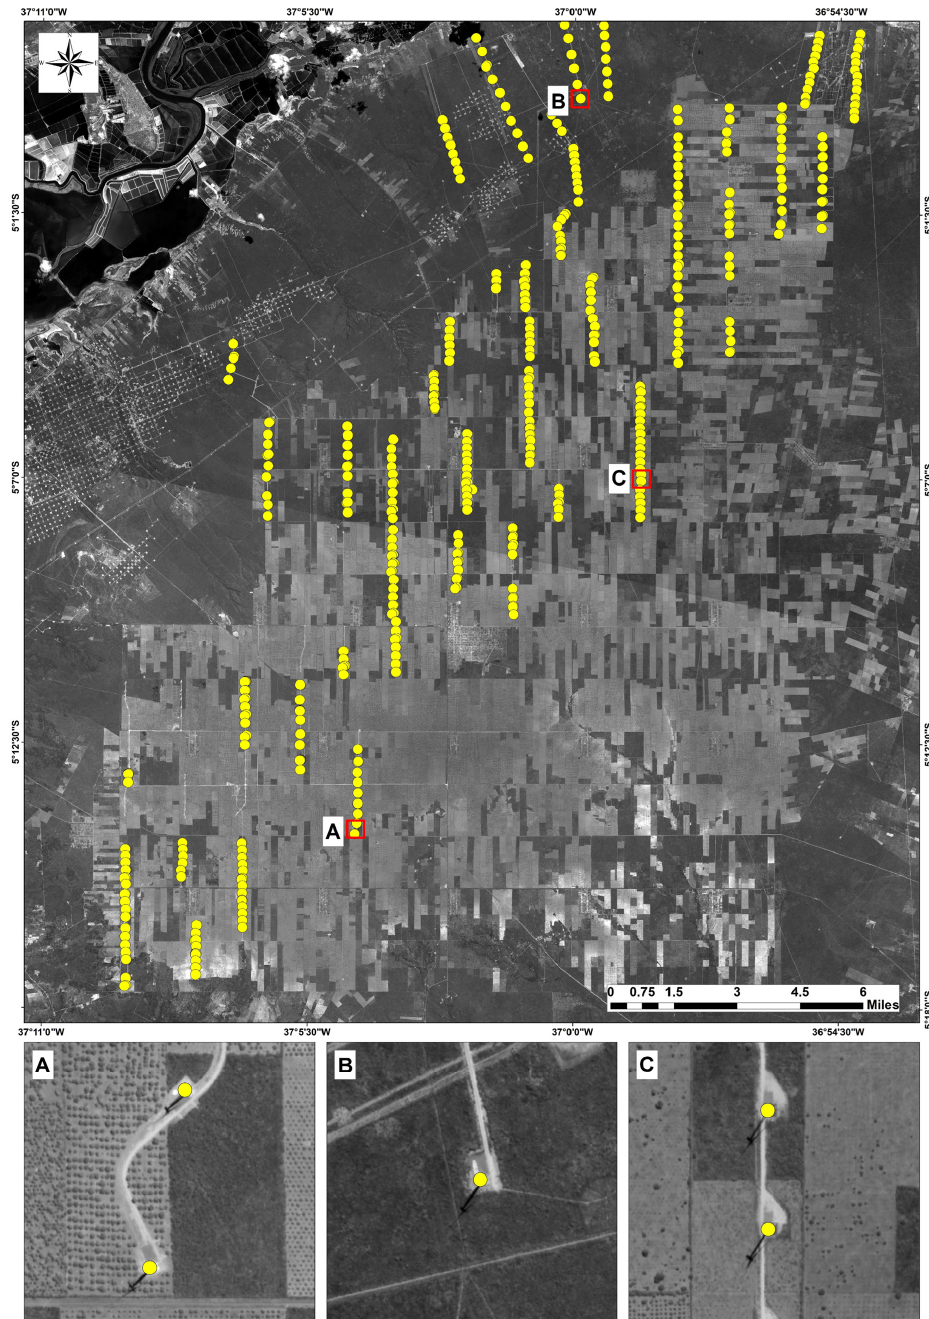
Figure 9. Mapping of the wind plants with three zoomed areas ( A – C ) considering point shapefile